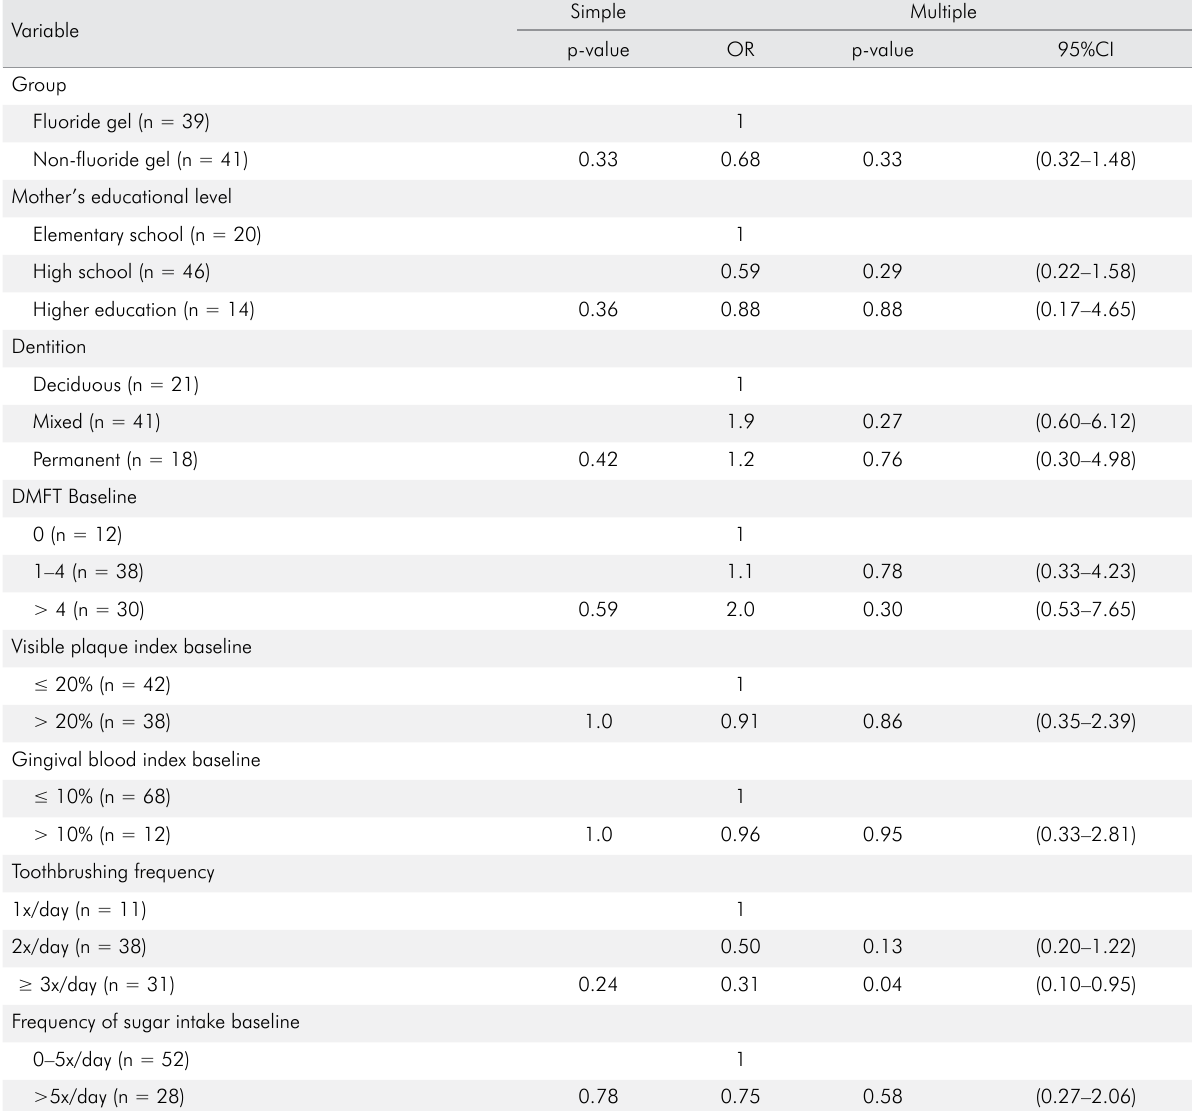
Table 2. Association between caries lesion control and explanatory variables (simple and multiple regression models). Variable